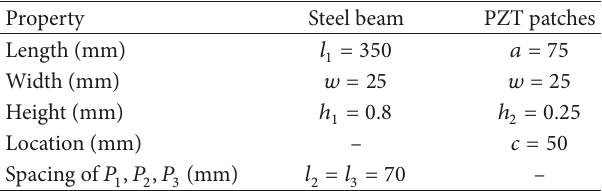
Figure 1: Cantilevered beam bonded with piezoelectric patches.